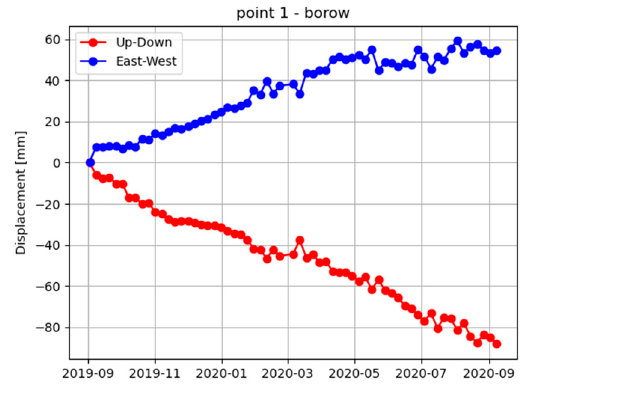
Figure 14. Up-down ( a ) and east-west ( b ) displacement maps of the area surrounding Przesieczna (area 3) and Borow (area 4), overlaid with the topographic contour lines of the selected area.